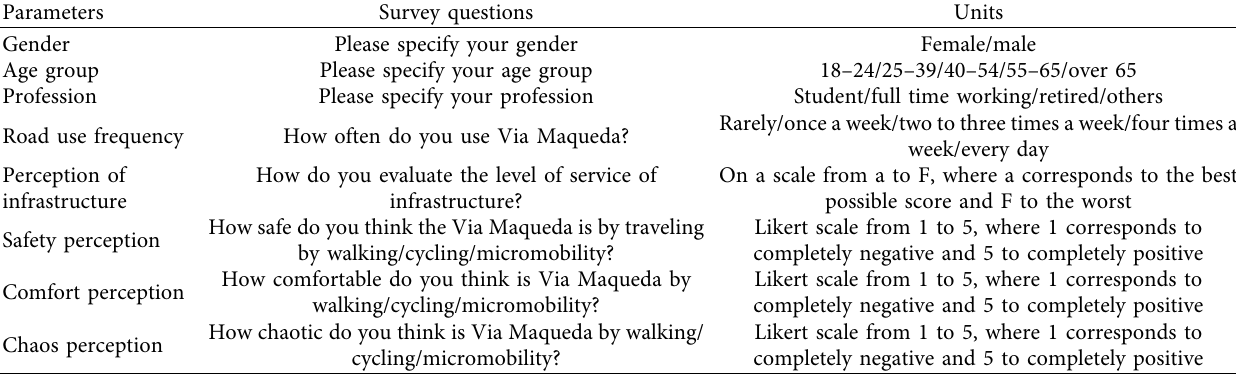
Table 1: Survey questions and units.